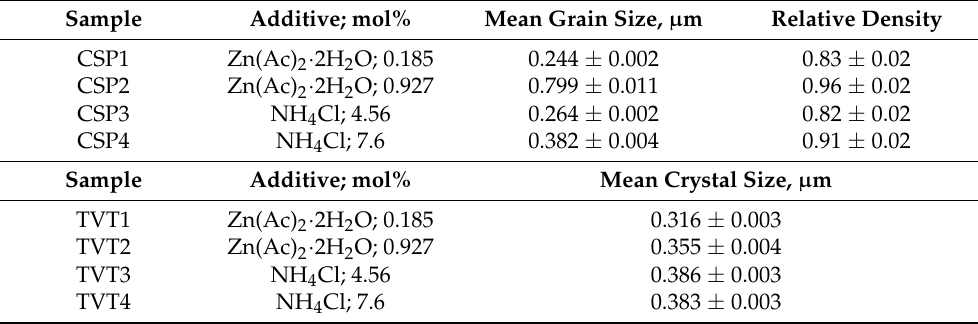
Table 4. The experimental